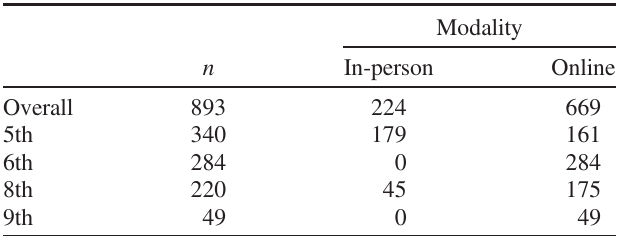
TABLE III. Number of questionnaires collected by grade and modality (in-person and